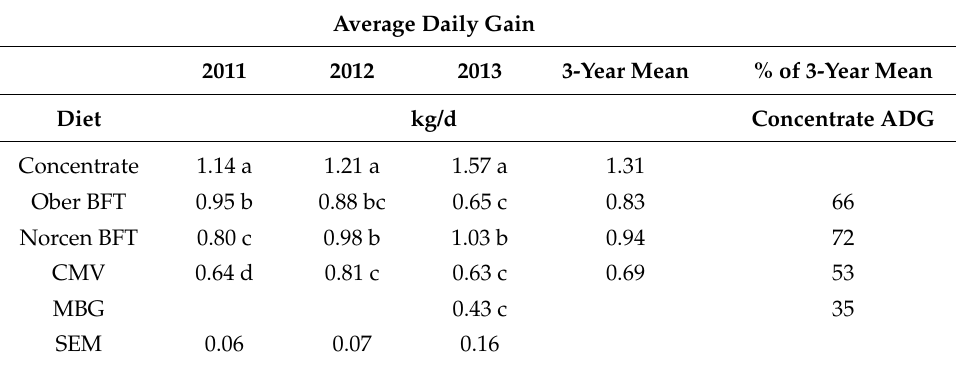
Table 4. LSMEANS of season-long average daily gain (ADG).